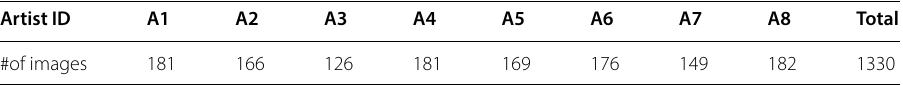
Table 1 Number of comic book pages in each class for the experiments Artist